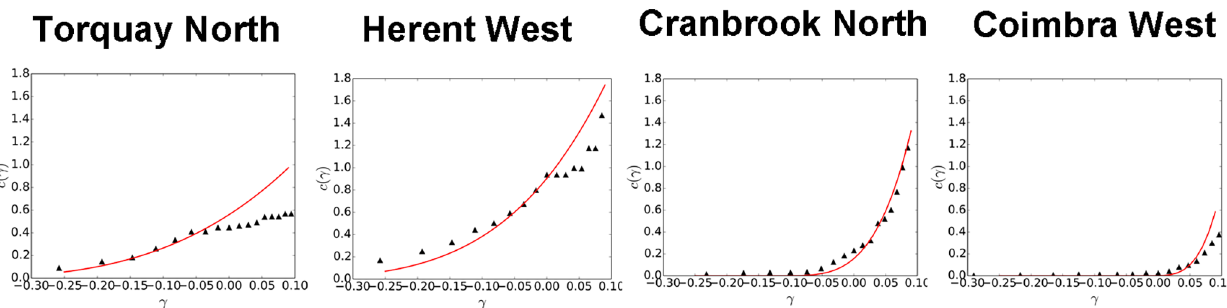
Figure 8. Functional box-counting analysis of the map of sub-catchments imperviousness for four selected catchments. Triangles: for each threshold 2 − D F (Fig. 7) vs. the corresponding singularity γ T is estimated as log (cid:51) T (cid:104) and equal to 50 here). Solid line: theoretical shape of c(γ) with UM parameters estimated with the help of DTM technique (Table 2).